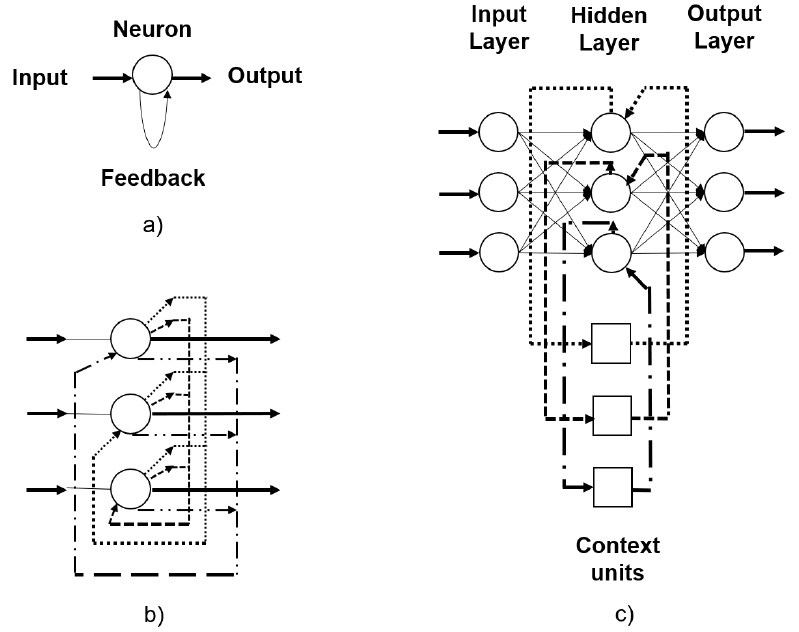
Figure 5. Recurrent neural networks structure: ( a ) Simple structure of a recurrent network, ( b ) Hopfield network structure, ( c ) Elman network structure.